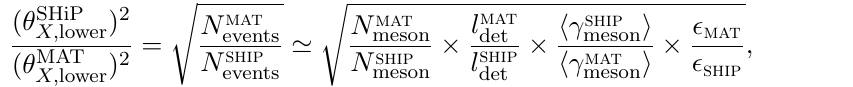
Figure 2 . The number of decay events for HNL with mass M = 3 GeV as a function of U 2 N = 10 14 , the γ factor is = 15, the efficiency (cid:27) = 1, and the number of mesons is taken N γ N meson (cid:31) (cid:30) = l = 50 m. The decay width can be found from eq. (B.6). The dashed blue distances l target-det det (Equation (3.1)), while the dashed red line corresponds to the estimate of line corresponds to U 2 max the upper bound based on eq. (3.3). Small discrepancy between the position of the upper bound and the estimate is caused by logarithmic errors in